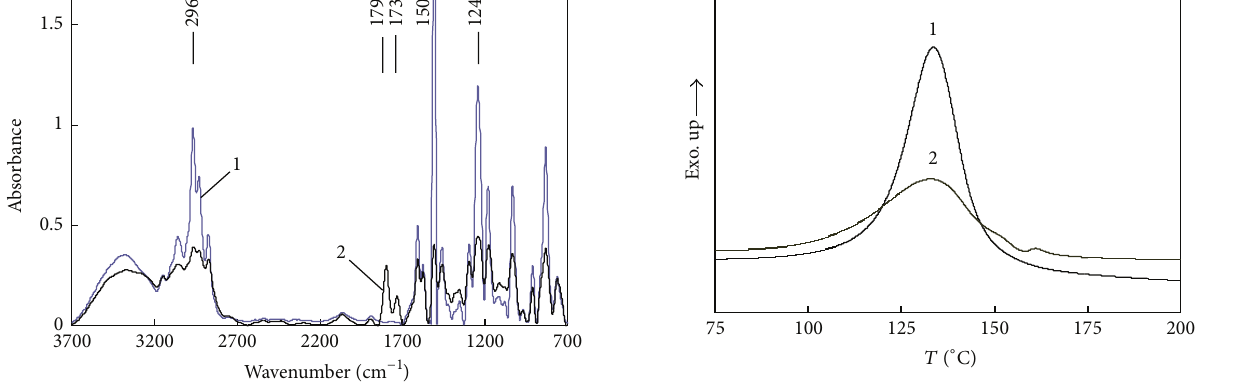
Figure 4: FTIR-spectrum of reaction mixture “1-butyl-3-methyli- midazolium bromide – ED-20 resin”: (1) initial mixture; (2) kept for 5 h at 100 ∘ C.